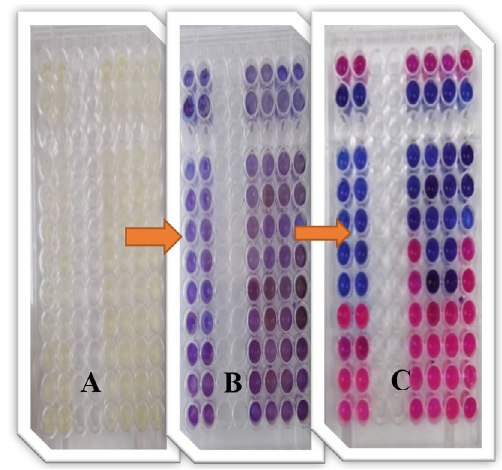
Fig. 14. Ninety-six well Microtiter plates of the colorimetric-XTT assay for determination of MICs values of ZnO NPs against bacterial strains using resazurin salt, (A) cart preparation, (B) after addition resazurin dye and (C) the results after incubation.